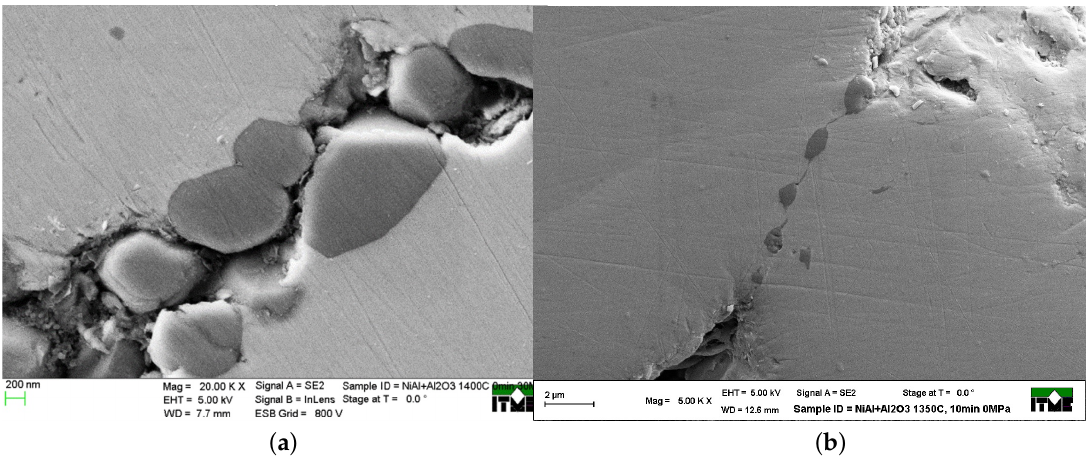
Figure 1. SEM images of NiAl/Al 2 O 3 composite: ( a ) material failure on the particle boundary area and ( b ) ceramic distribution on the particle boundary of intermetallic